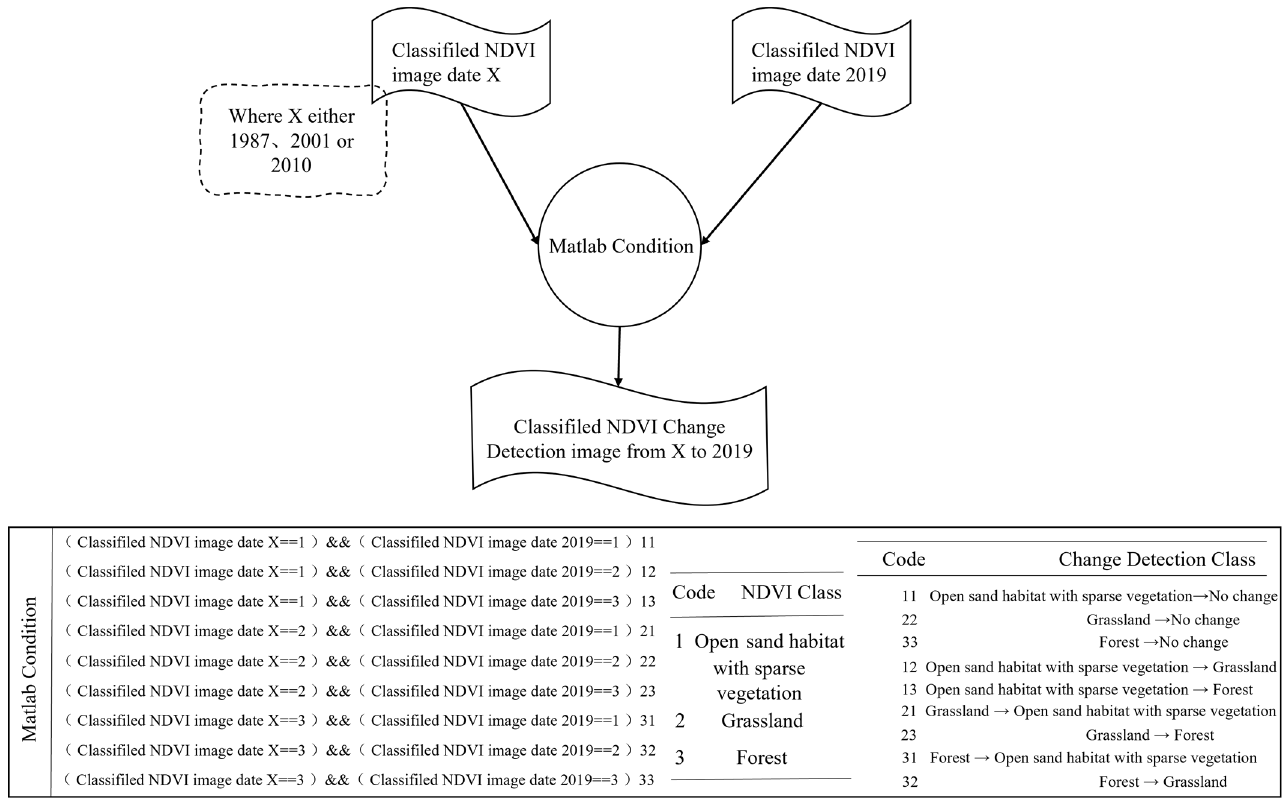
Figure 3. Flow chart.